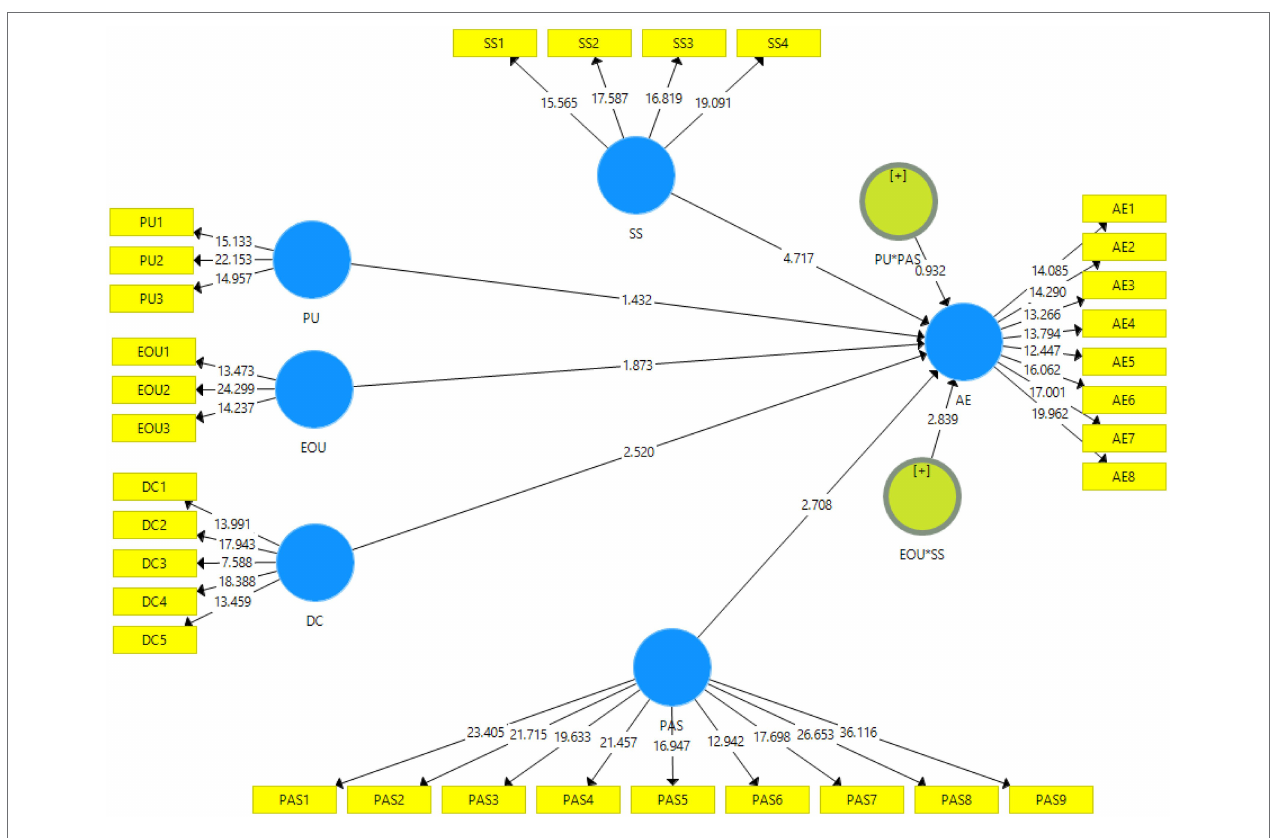
FIGURE 3 | Bootstrapping.